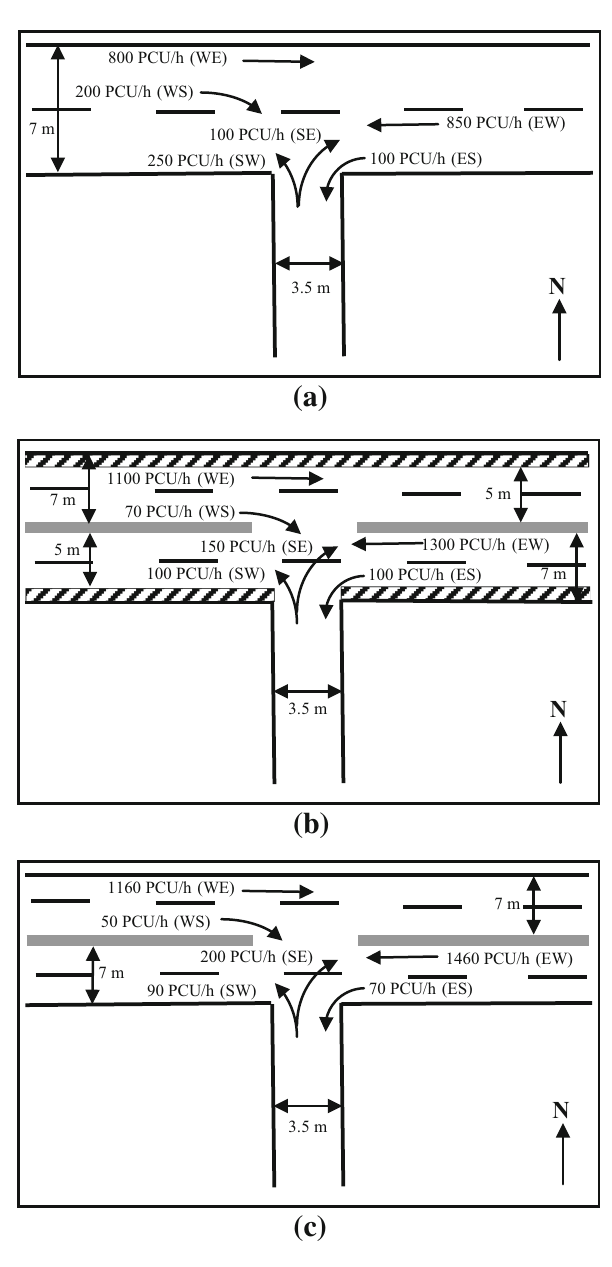
Fig. 4 Geometric features and traffic composition of a intersection A, b intersection B and c intersection